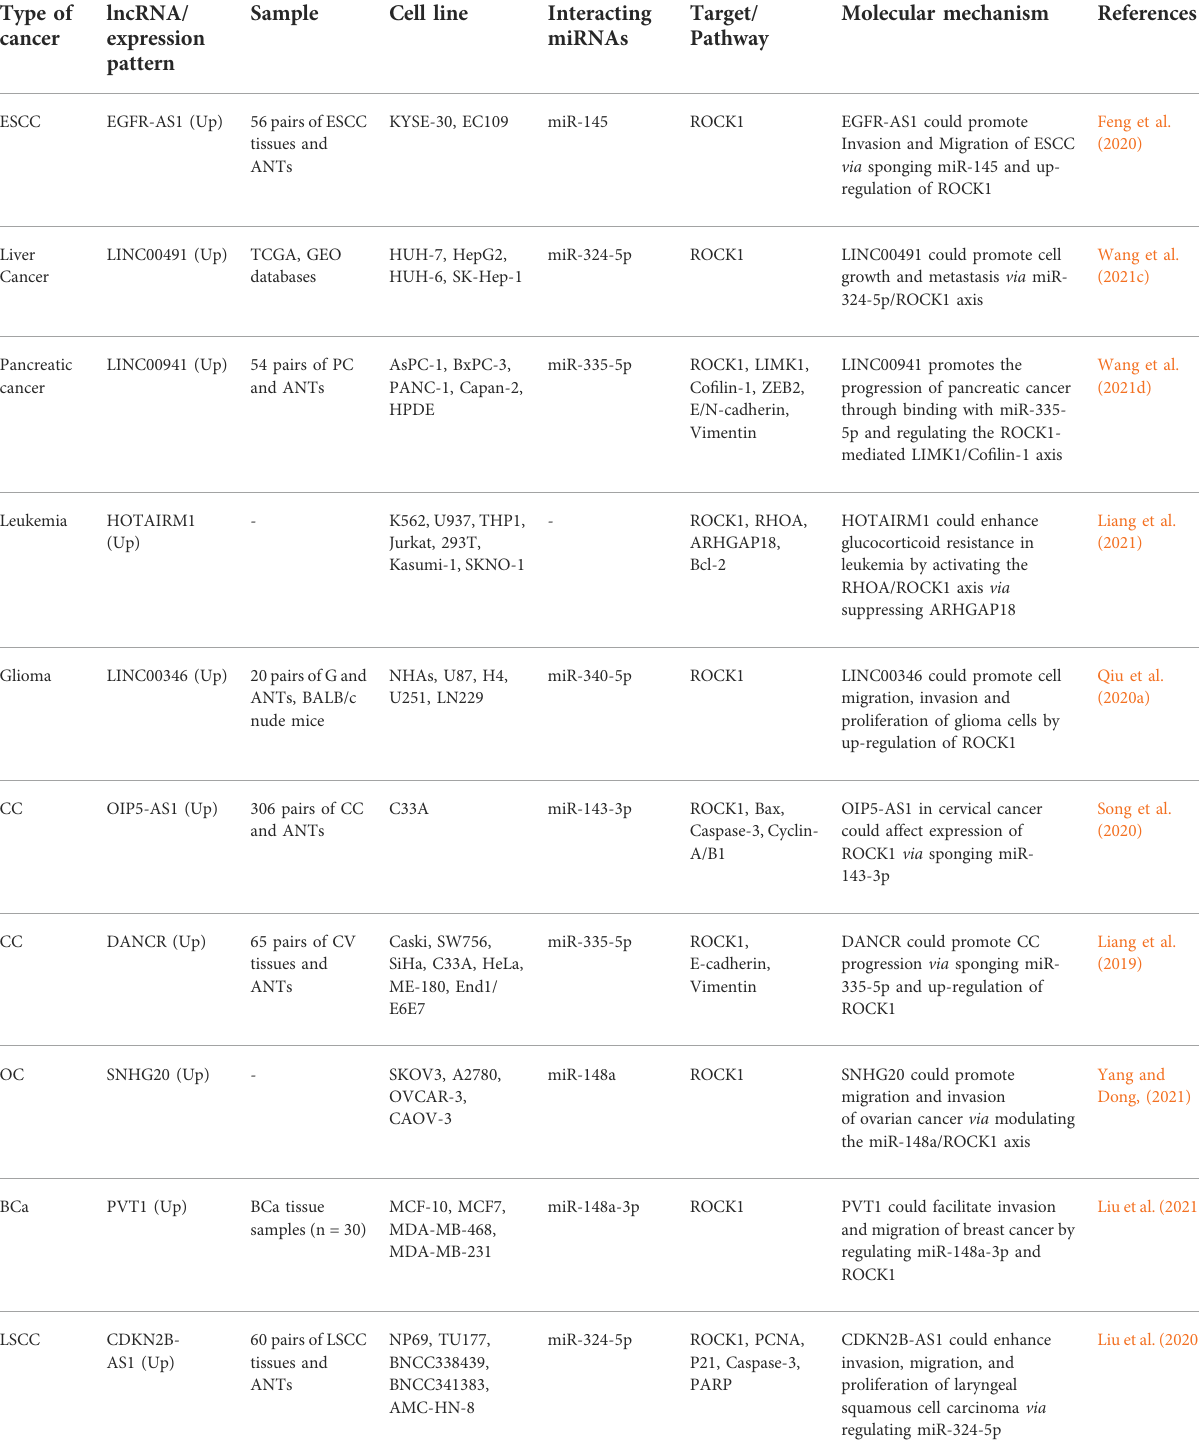
TABLE 6 ( Continued ) ROCK1-interacting lncRNAs in cancers (ANT: adjacent non-cancerous tissue, NSCLC: non-small cell lung cancer, OS: osteosarcoma, HCC: hepatocellular carcinoma, ESCC: Esophageal squamous cell carcinoma, CC: cervical cancer, OC: ovarian cancer, BCa: breast cancer, LSCC: Laryngeal squamous cell